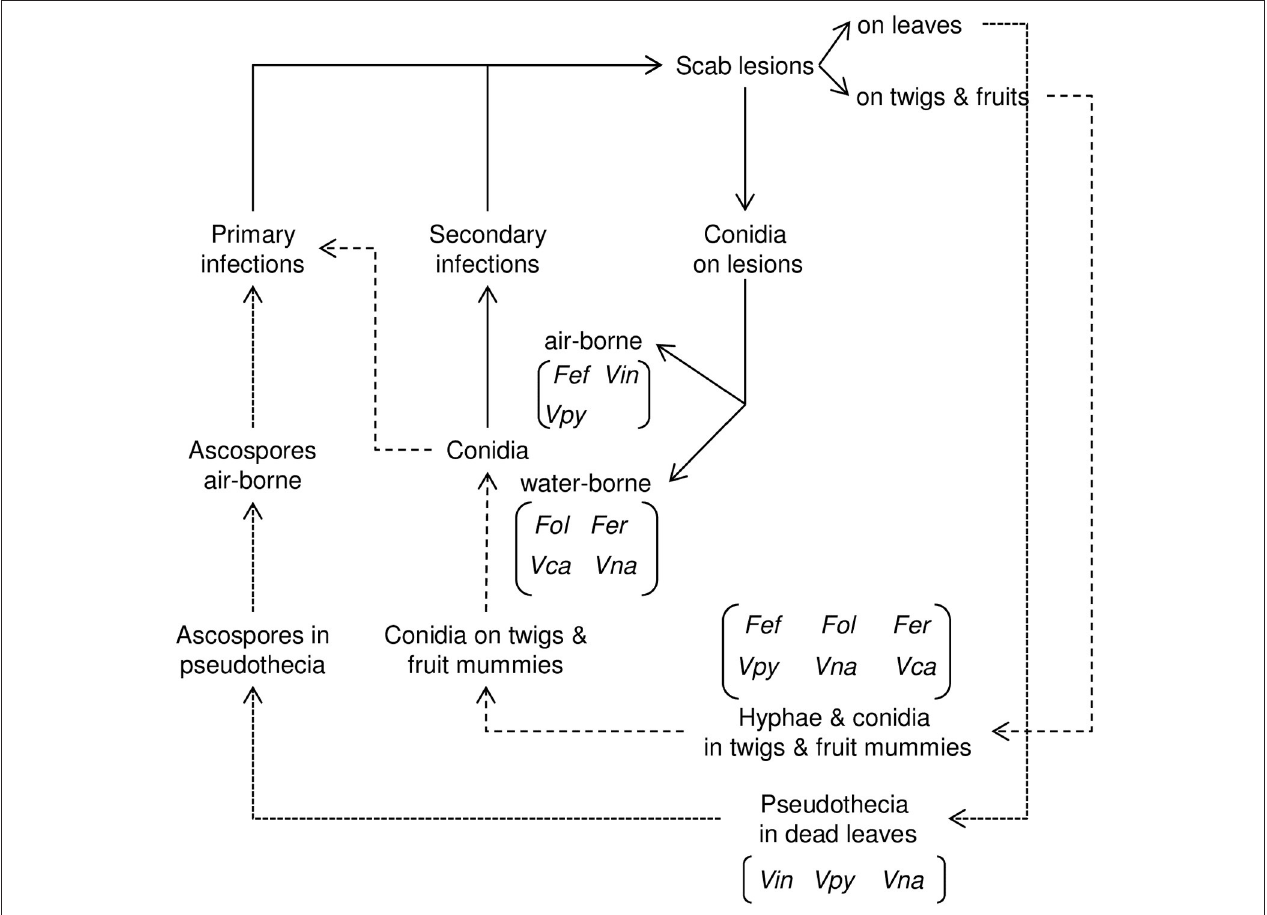
FIGURE 3 | Relational diagram of the life cycle of Venturia spp. Dotted lines (…) indicate the sexual phase of the life cycle; dashed lines (-----) indicate the asexual phase of the life cycle. The species of Venturia in which the different stages occur are indicated in brackets. Fef, Fusicladium effusum ; Fer, Fusicladium eriobotryae ; Fol, Fusicladium oleagineum ; Vca, Venturia carpophila ; Vin, Venturia inaequalis ; Vna, Venturia nashicola ; Vpy, Venturia pyrina